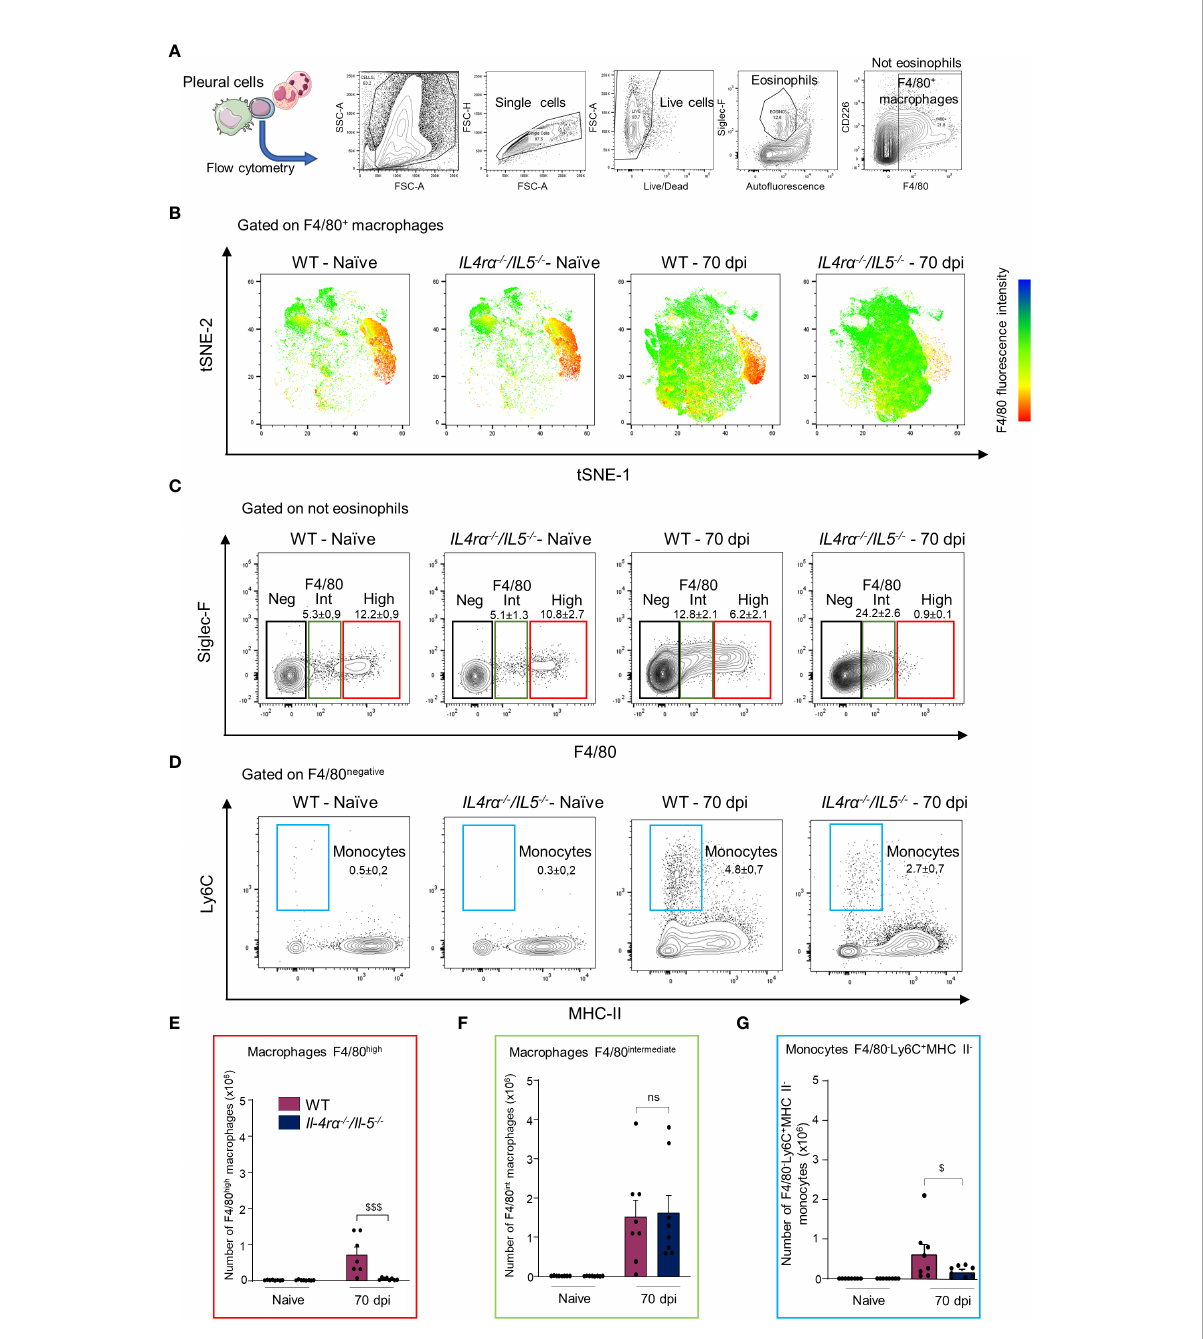
FIGURE 4 Pleural macrophages from Il-4r a -/- /Il-5 -/- mice fail to mature into resident macrophages. Pleural cells were isolated from L. sigmodontis infected WT and Il-4r a -/- /Il-5 -/- BALB/c mice at 70 dpi and analyzed by fl ow cytometry for F4/80, Ly6C, MHCII and Siglec-F. (A) Experimental setup and gating strategy. (B) Samples were concatenated and a tSNE was performed on F4/80 + cells. (C) Representative plots and gating strategy for F4/80 intermediate and F4/80 high macrophages and for naïve and infected WT and Il-4r a -/- /Il-5 -/- BALB/c mice. An alternative gating strategy for F4/80 intermediate and F4/80 high including a CD11b and CD115 pre-gating is displayed in Supplementary Figure 3. (D) Representative plots and gating strategy for F4/80 - MHCII - Ly6C + monocytes. (E) Absolute numbers of F4/80 high macrophages. (F) Absolute numbers of